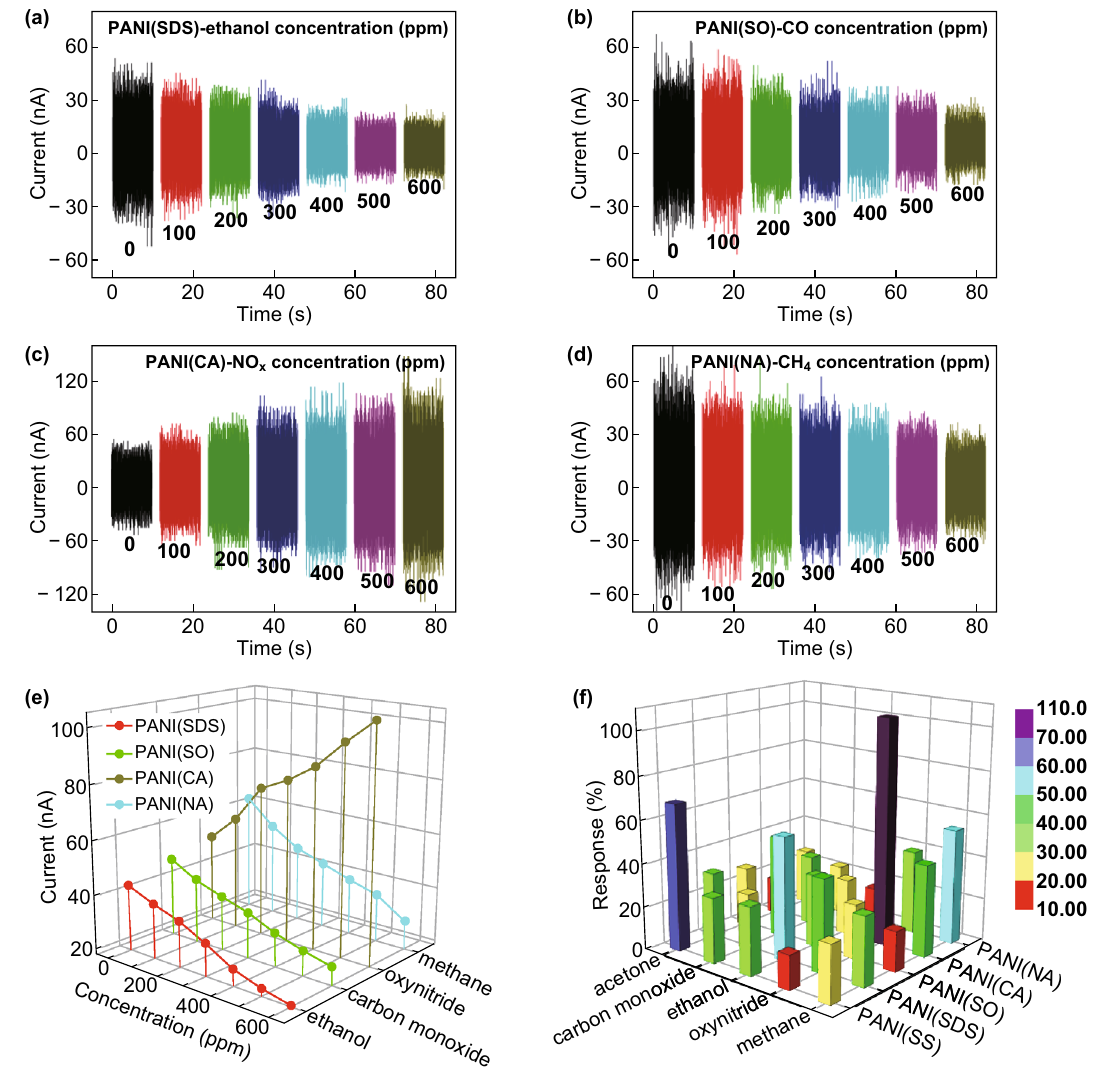
Fig. 4 Sensing performances of the five sensing units. The output current of a PANI(SDS) unit under different ethanol concentrations. b PANI(SO) unit under different CO concentrations. c PANI(CA) unit under different NO x concentrations. d PANI(NA) unit under different CH 4 concentrations. e The relationship of the four units between the output current and special gas marker concentration. f The response of the five sensing units to 600 ppm